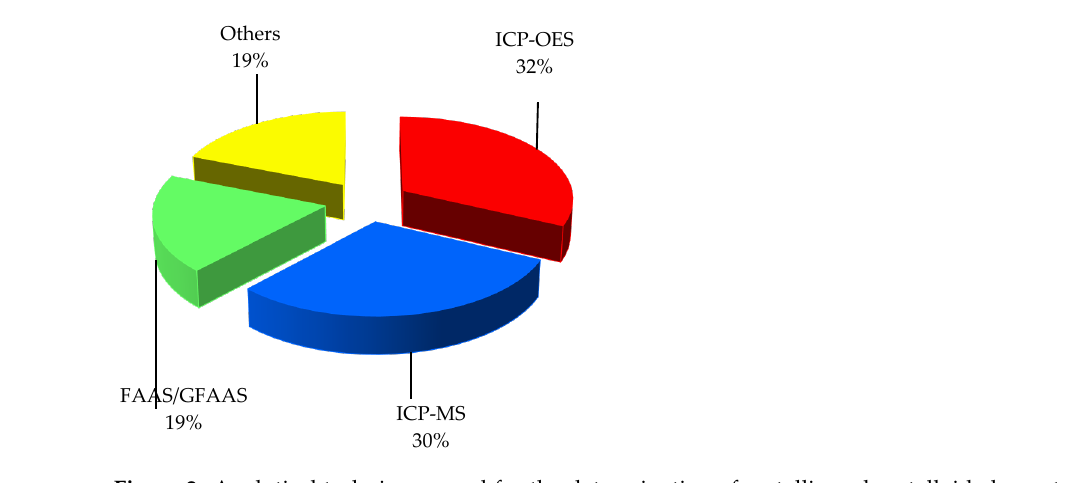
Figure 2. Analytical techniques used for the determination of metallic and metalloid elements in digests and extract solutions of APM samples.